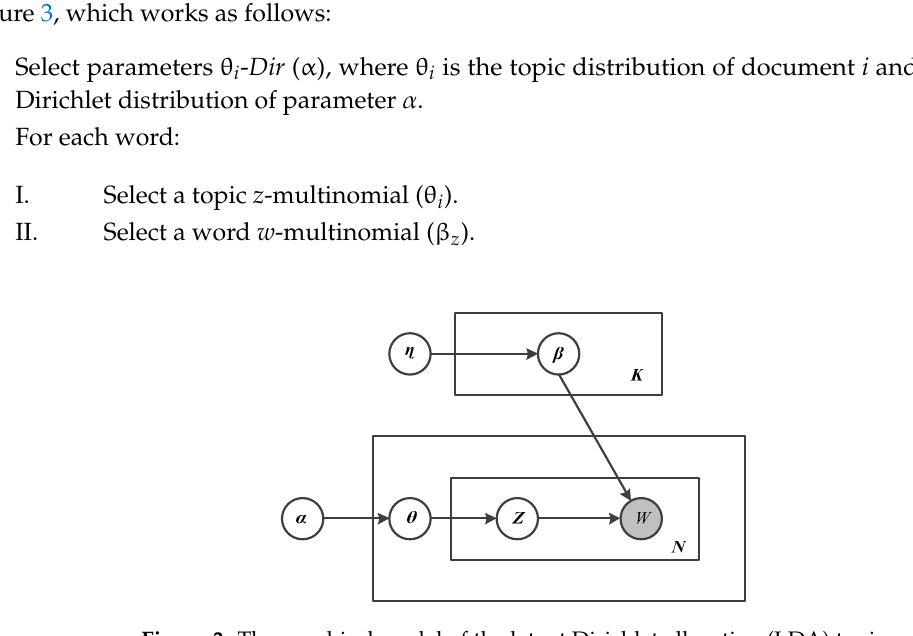
Figure 3. The graphical model of the latent Dirichlet allocation (LDA) topic.